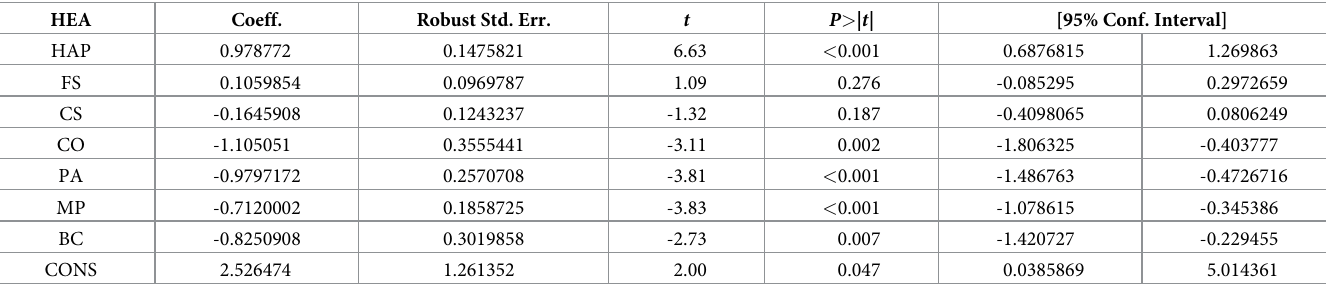
Table 2. The empirical estimation of the life model’s regression coefficients. HEA Coeff. Robust Std.